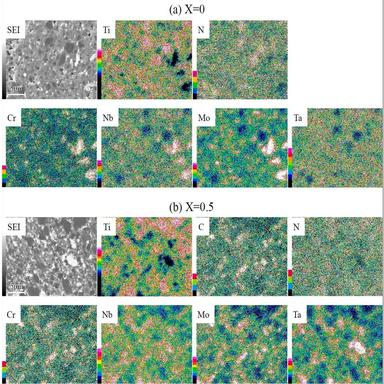
EDS maps of TiCXN1-X-TiCrNbMoTa composites (a) X = 0 (b) X = 0.5 (c) X = 0.7 (d) X = 1.0.